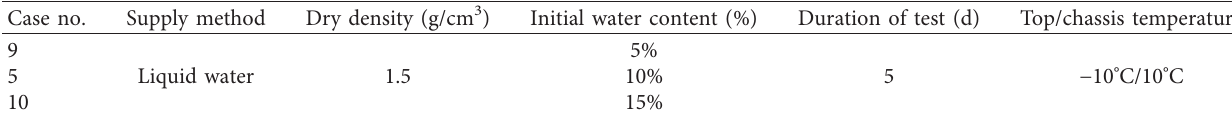
Table 4: Influence of initial water content in SSH.